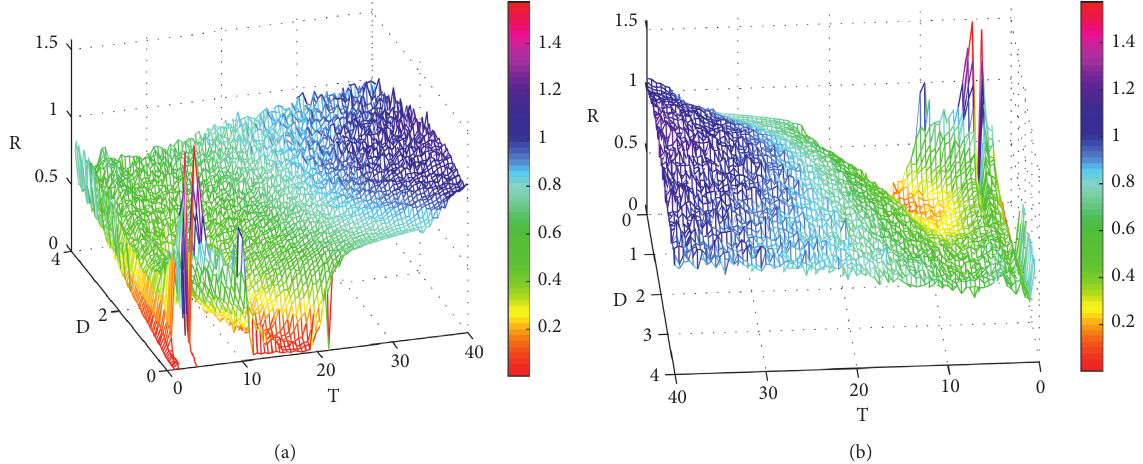
Figure 10: When the parameters of flux-controlled memristor are determined, the periodic variation diagram of coherence resonance coefficient R of FHN neuron system with noise intensity D and period T of phase noise. (a) Top view; (b) Back